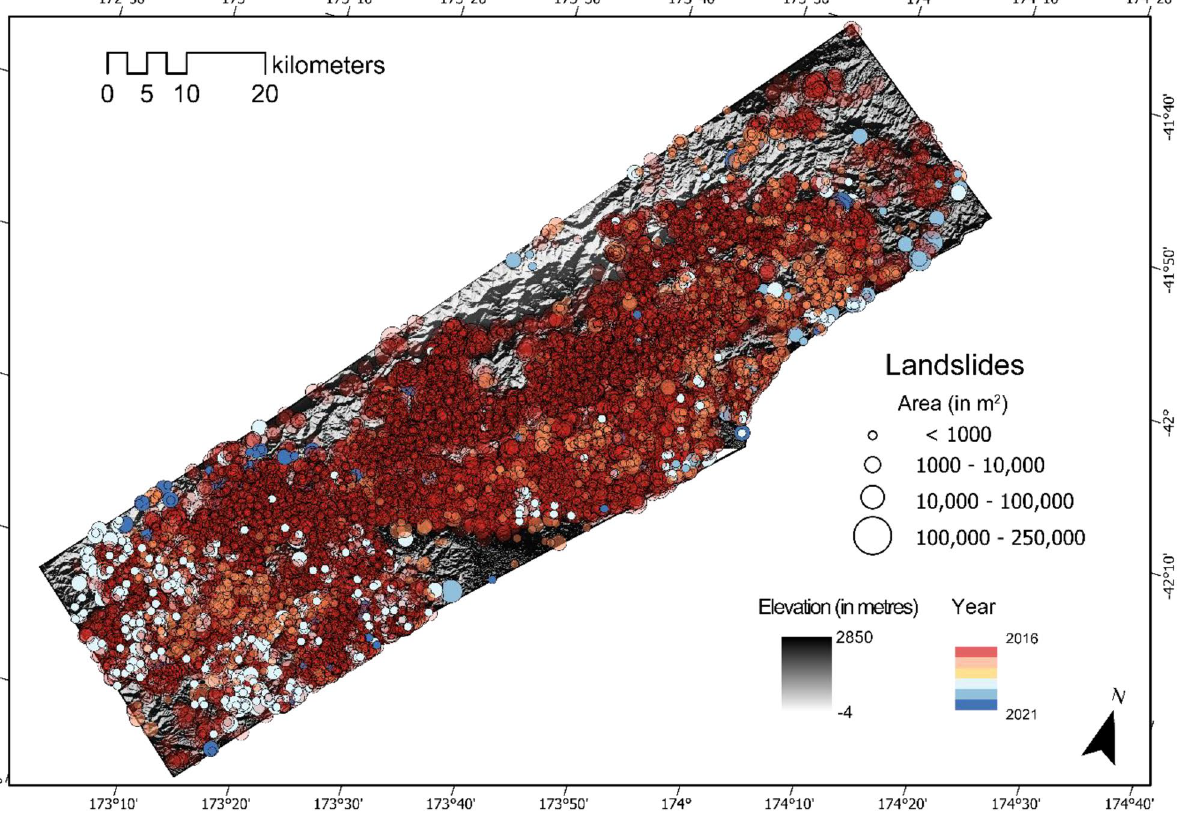
Figure 8. Multi-temporal landslide inventory of Kaikōura, New Zealand from 2016 till 2021. The location, area (in m 2 ), and the year of the inventories are depicted above (see Table S4 in the Supplementary Materials for the landslide statistic indicating differences between the GI and the PI for each year in the testing windows). Shaded relief base map credits: World Shaded